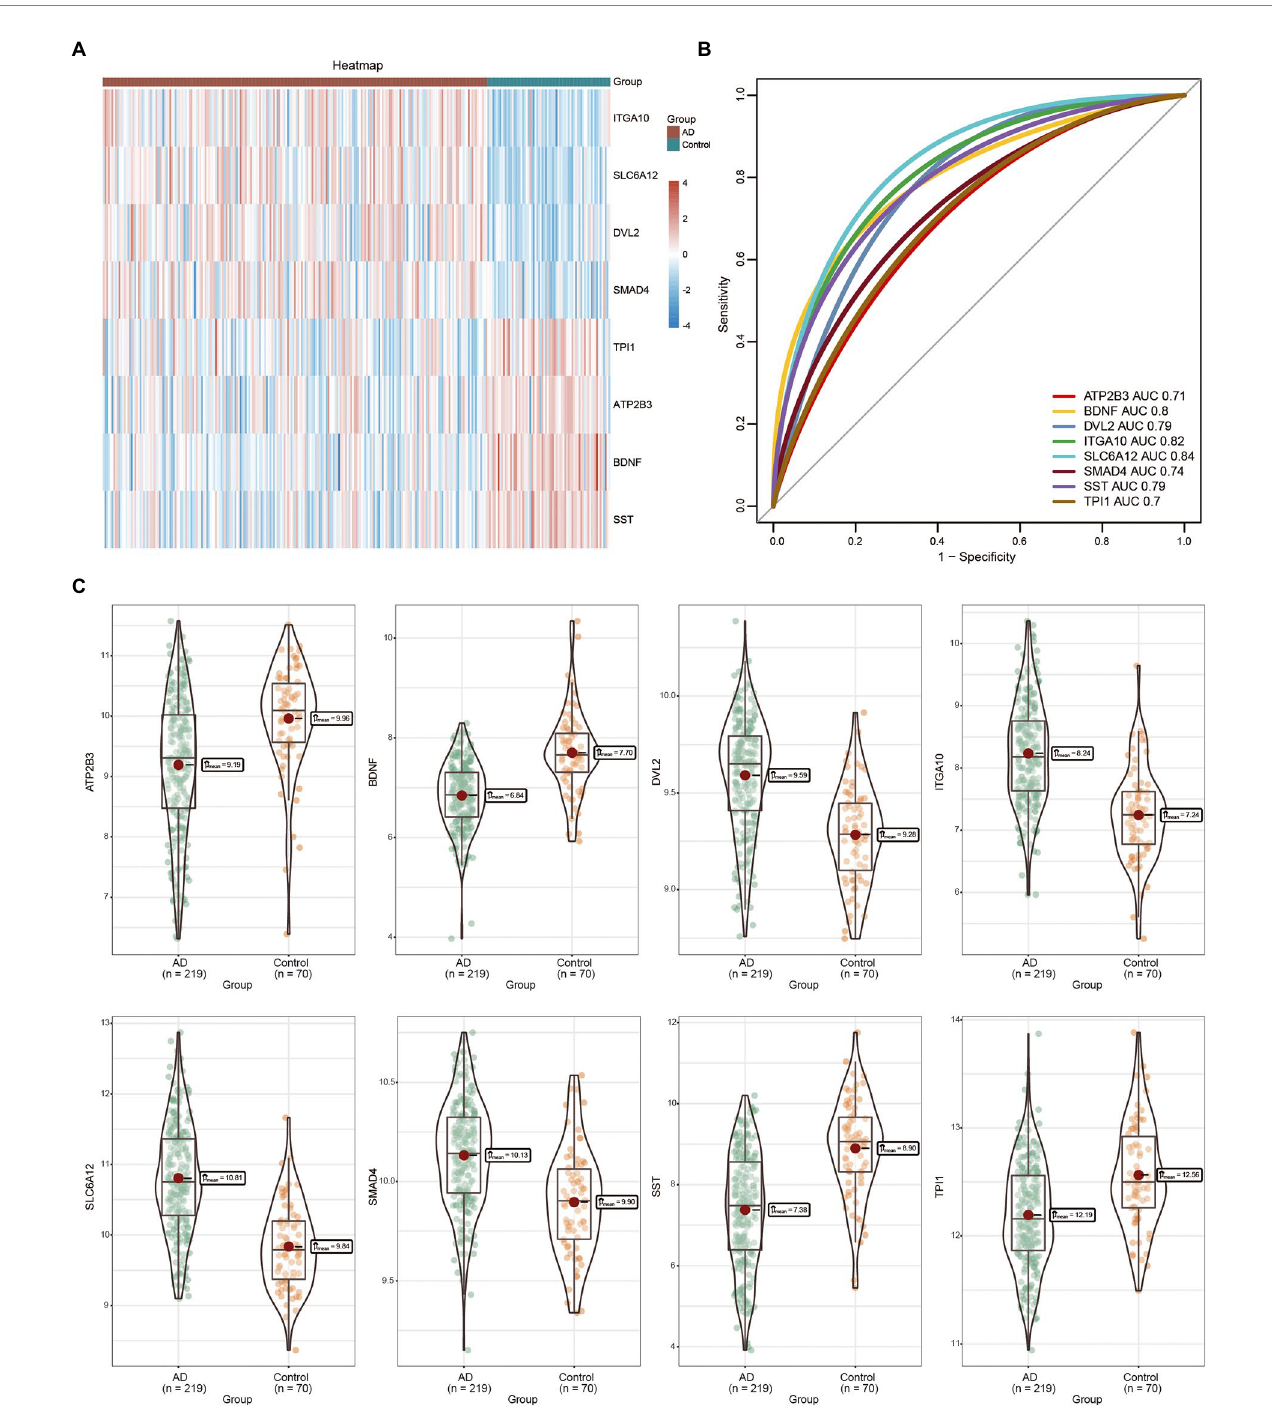
FIGURE 4 Expression of feature genes between Alzheimer’s disease (AD) and control groups. (A) The heatmap represents the expression of eight feature genes in AD and control groups. Red indicates high expression, blue indicates low expression. (B) Area under the curve of the eight feature genes. (C) Box diagram of the eight feature genes differentially expressed in AD and control groups. The thick black bar in the middle indicates the interquartile range, the black line extending indicates the 95% confidence interval. AD, Alzheimer’s disease; AUC, area under the